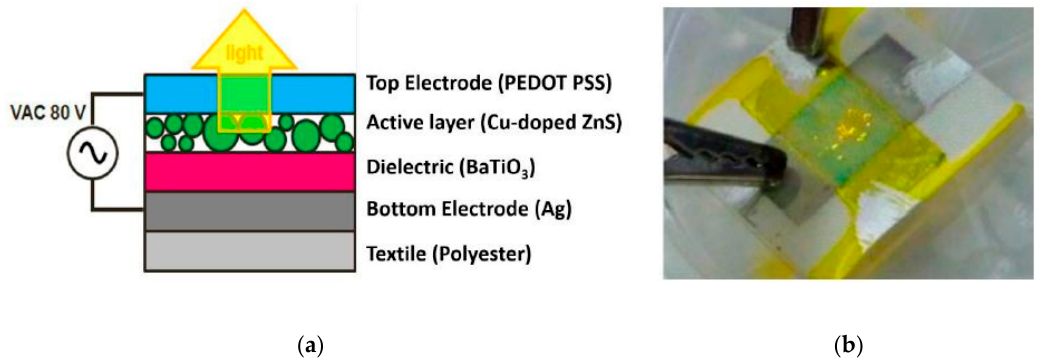
Figure 9. ( a ) Build-up of the alternating current powder electroluminescence technology; ( b ) OLED stack printed on a textile. Adapted from [108].